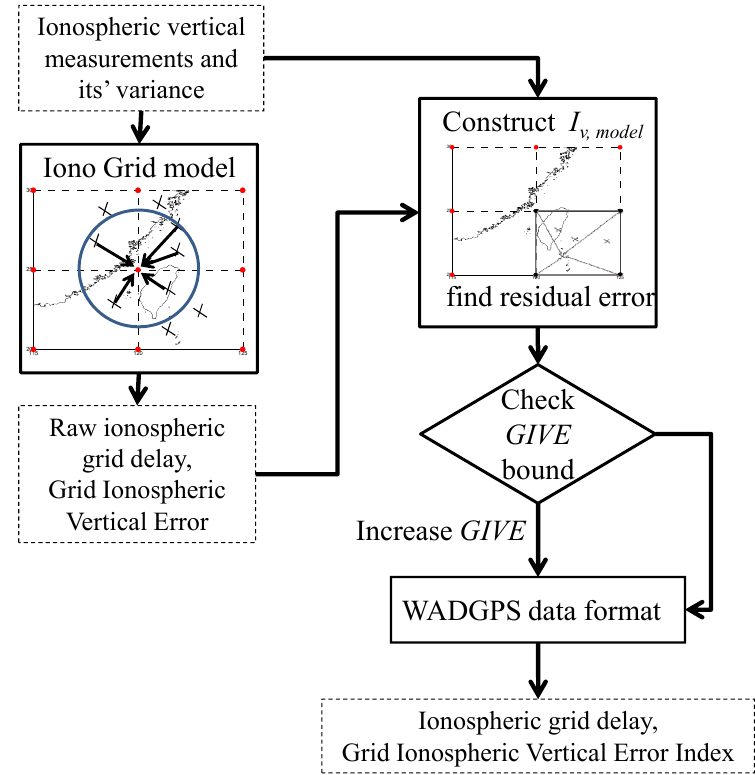
Figure 6. The feedback algorithm for